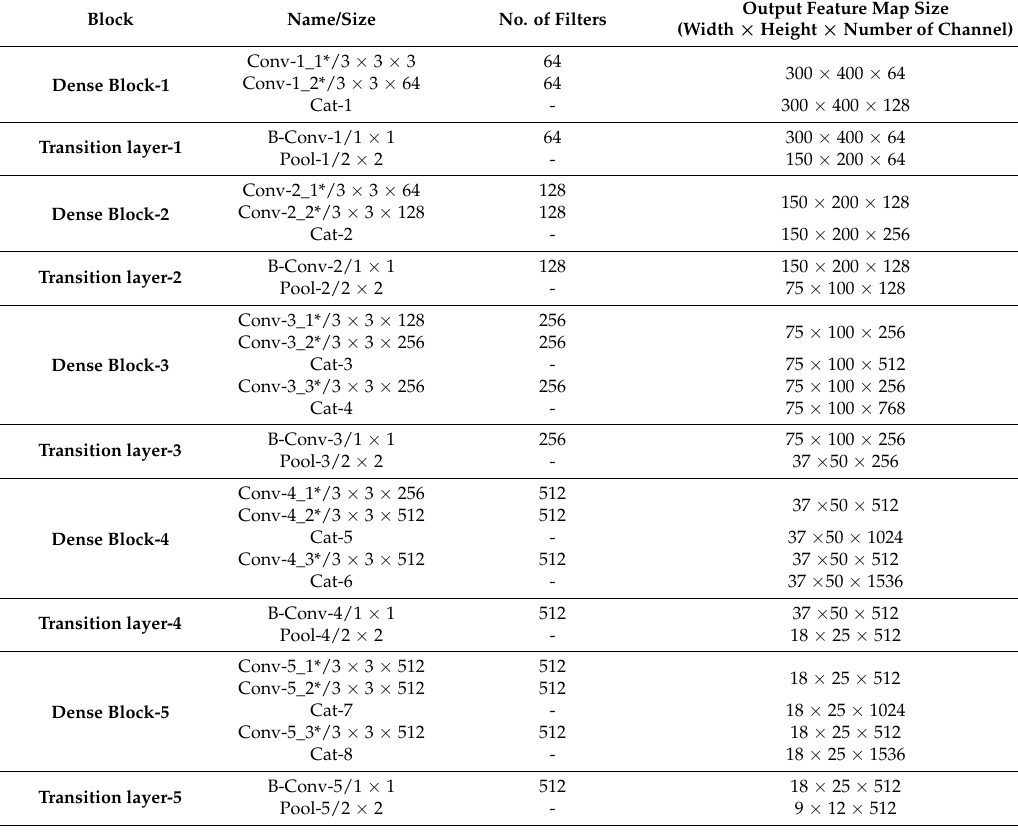
Table 2. IrisDenseNet connectivity and output feature map size of each dense block (Conv, BN, and ReLU represent convolutional layer, batch normalization layer, and rectified linear unit layer, respectively. Cat, B-Conv, and Pool indicate concatenation layer, bottleneck convolution layer, and pooling layer, respectively) (Here, dense blocks 1 and 2 have the same number of convolution layers, and dense blocks 3, 4, and 5 have the same number of convolution layers) (Convolutional layers with “*” mean that these layers include BN and ReLU. Transition layers are a combination